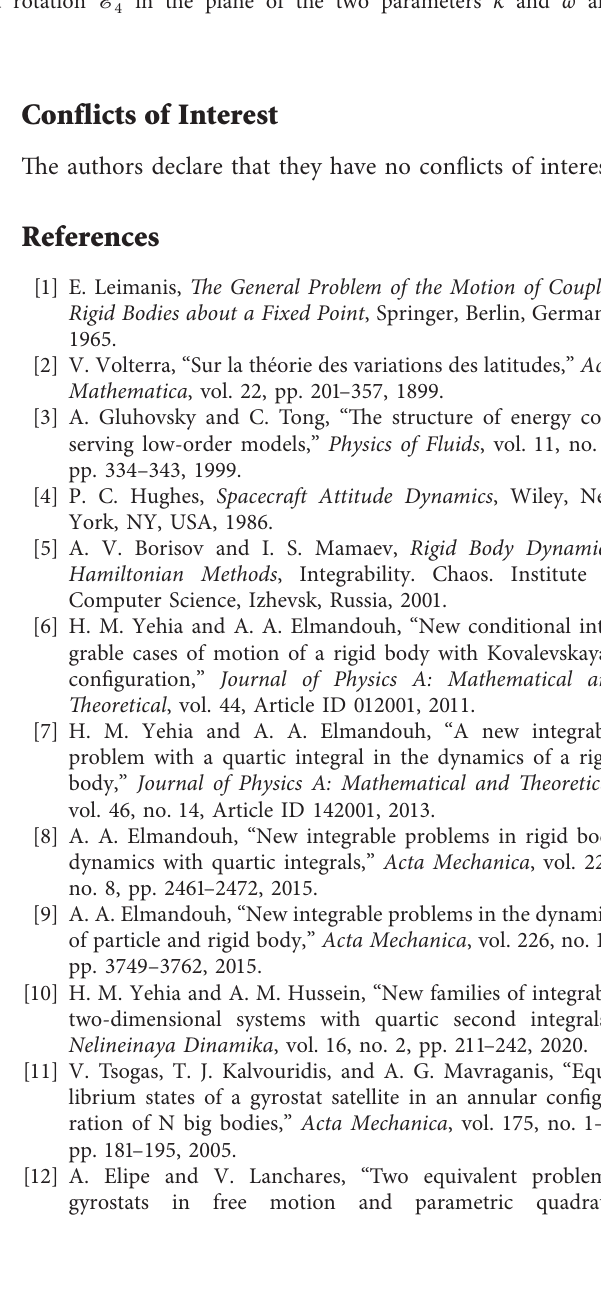
in the plane of the two parameters k and ω and 4